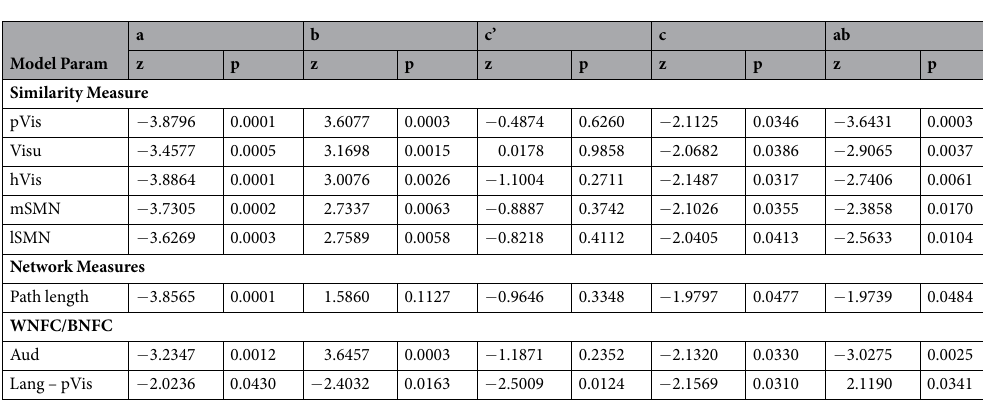
Table 2. Results of mediation analysis for the model (Fig. 1b) where a given connectivity measure (similarity, network, or within- and between-network functional connectivity measures) mediated the relationship between age and ACE-R total score. Sex was controlled in all regression analyses. a is the coefficient relating the independent variable (age) to the mediator (connectivity measure), b is the coefficient relating the mediator to the dependent variable (ACE-R total score), c ’ is the coefficient relating the independent variable to the dependent variable adjusted for the mediator, c is the coefficient relating the independent variable and the dependent variable without mediation, and ab is the (mediated) indirect effect. z corresponds to the standardized value and p the corresponding p -value computed using bootstrap method (10,000 samples).